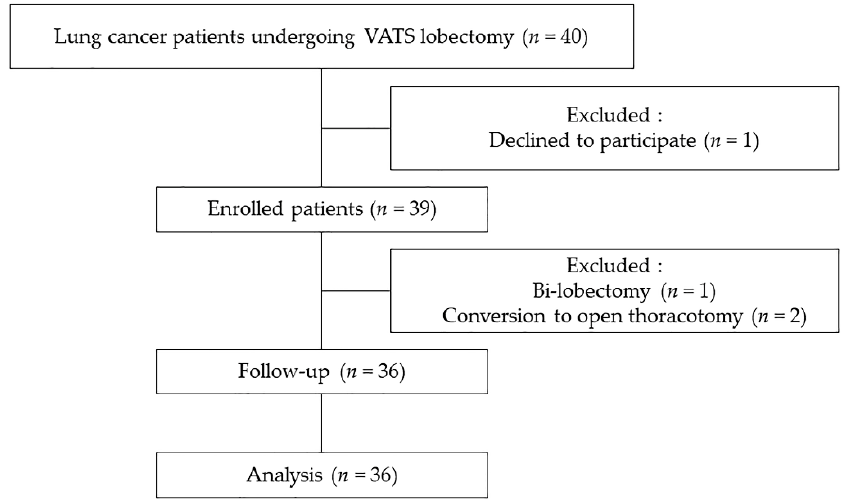
Figure 2. Flow chart of patient enrollment. VATS, video-assisted thoracoscopic surgery. Table 1. Patients’ characteristics and results of intra-operative data.